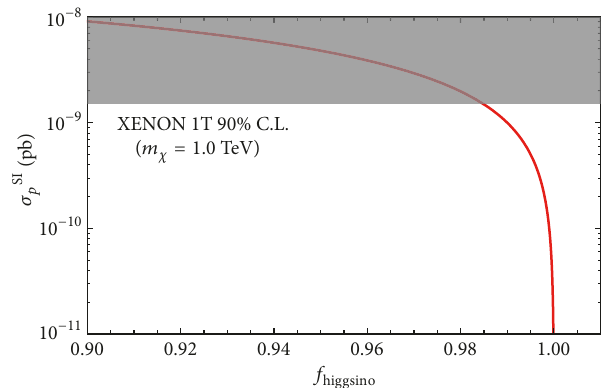
Figure 3: The neutralino-proton spin-independent cross section, 𝜎 SI 푝 , for a typical case of predominantly higgsino-like neutralino DM with 𝑚 휒 = 1.0 TeV as a function of higgsino purity 𝑓